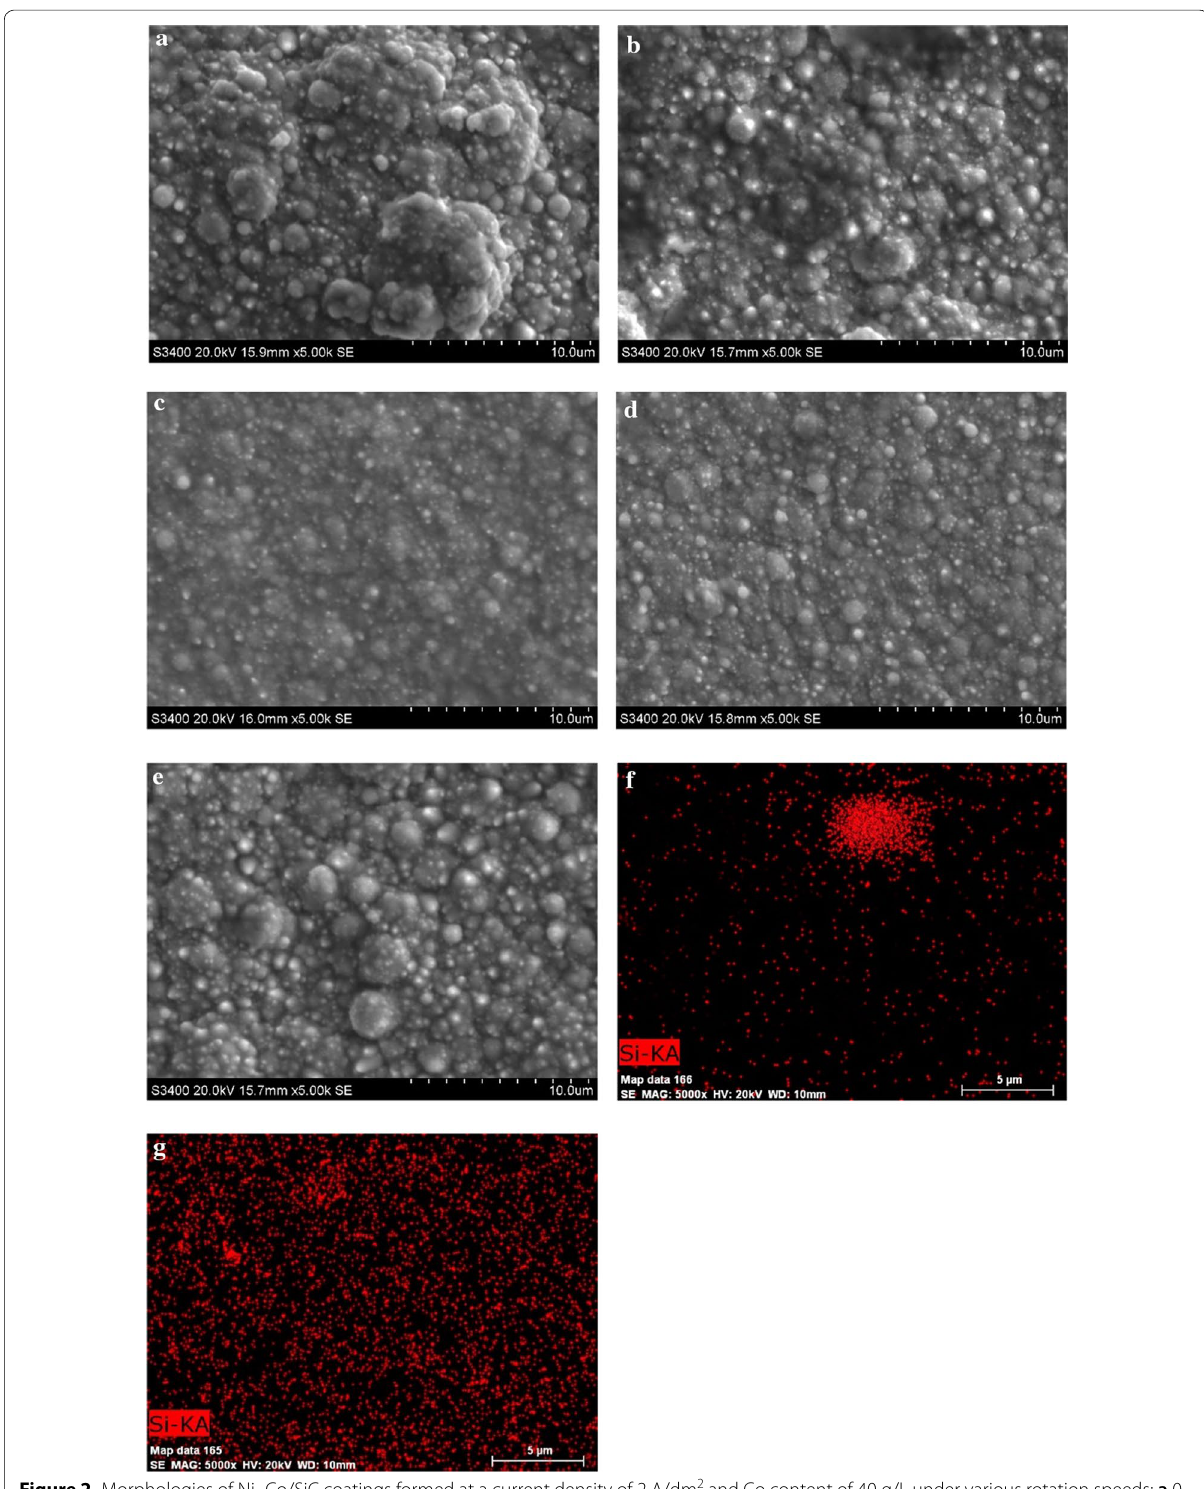
Figure 2 Morphologies of Ni–Co/SiC coatings formed at a current density of 2 A/dm 2 and Co content of 40 g/L under various rotation speeds: a 0 r/min, b 400 r/min, c 800 r/min, d 1200 r/min and e 1600 r/min; f Image for Si distribution of c , g Image for Si distribution of